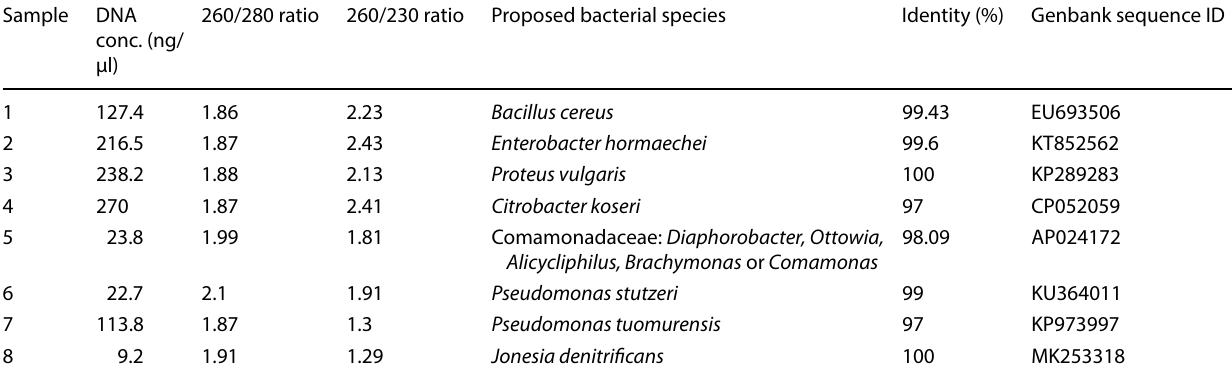
Table 1 DNA purity, proposed bacterial species based on identity found in GenBank Sample DNA conc. (ng/